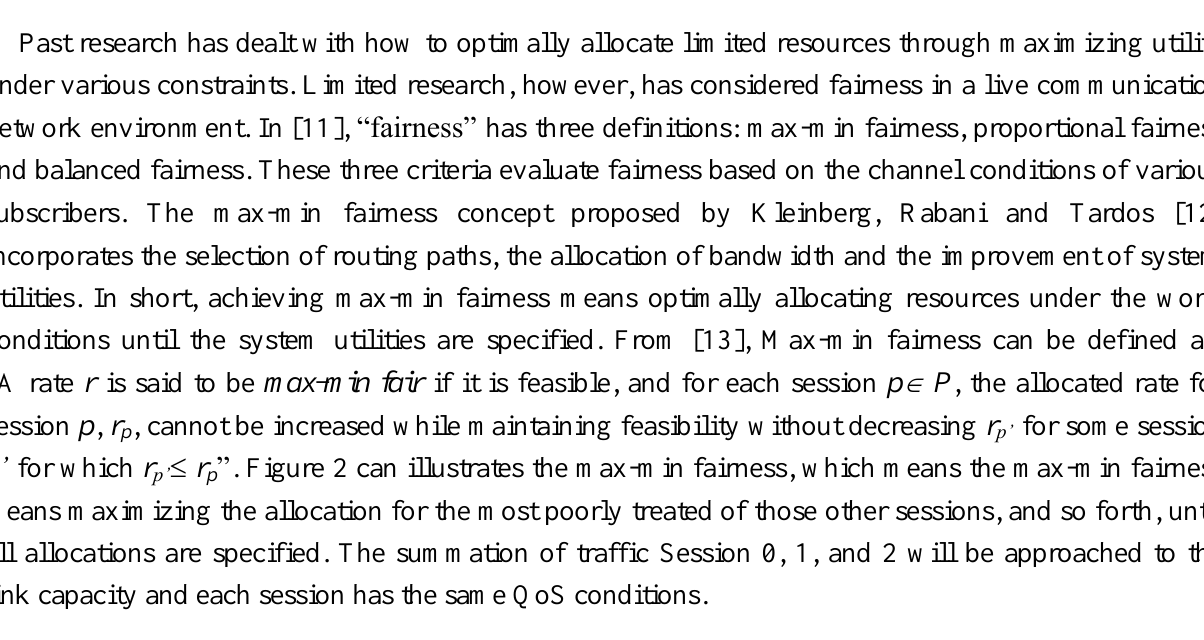
Figure 2. Max-min